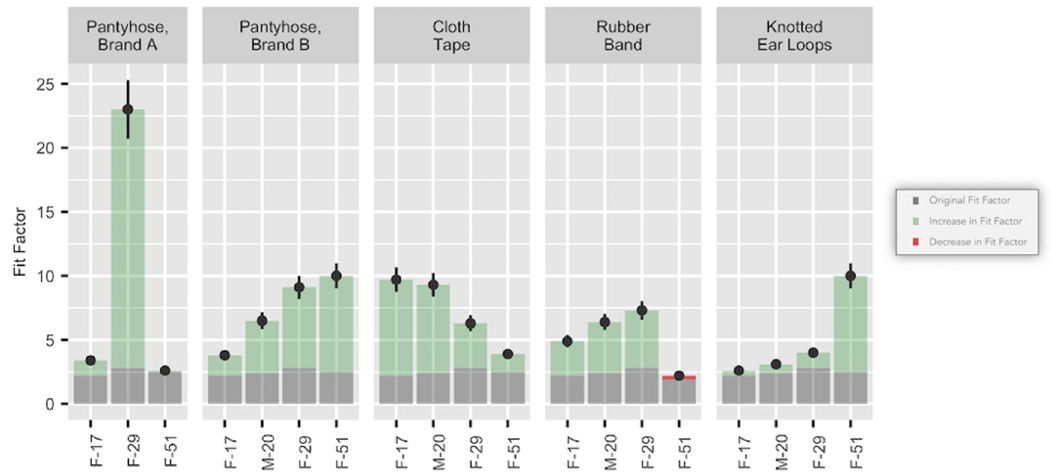
Fig 3. Fit hacks applied to surgical masks. Gray portions of the bars indicate the performance without the application of a fit hack. Green portions of the bars indicate improvement gained with the application of a fit hack. The red portion of the bar indicates a decrease in performance from applying the fit hack.